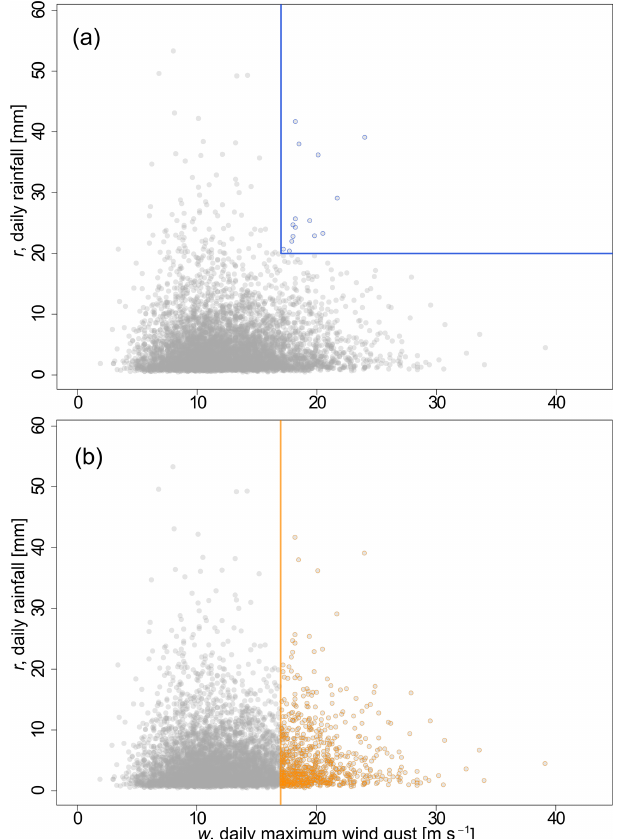
Figure 1. Illustration of joint and conditional extremes with daily rainfall r (mmd − 1 ) and daily maximum wind gust w (ms − 1 ) data at Heathrow Airport for the period 1971–2018: (a) joint extremes (AND) of rainfall and wind gust (blue circles); (b) conditional ex- tremes of rainfall given that wind gust is extreme (yellow circles). Daily rainfall data from E-OBS (Cornes et al., 2018) and daily max- imum wind gust (3s period) data from the Met Office